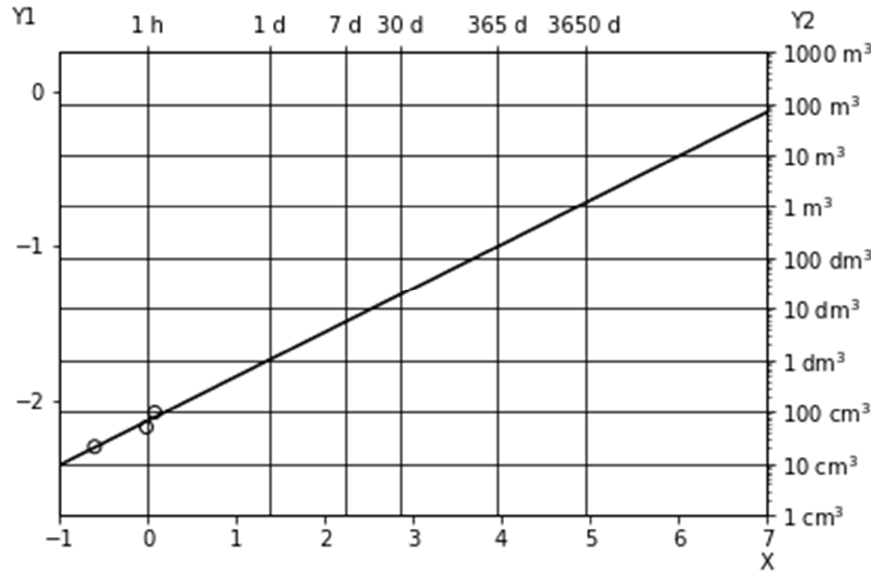
Figure 11. Dependence of the induction time of the combustion (t i ) on the volume/surface ratio of the sludge dust.